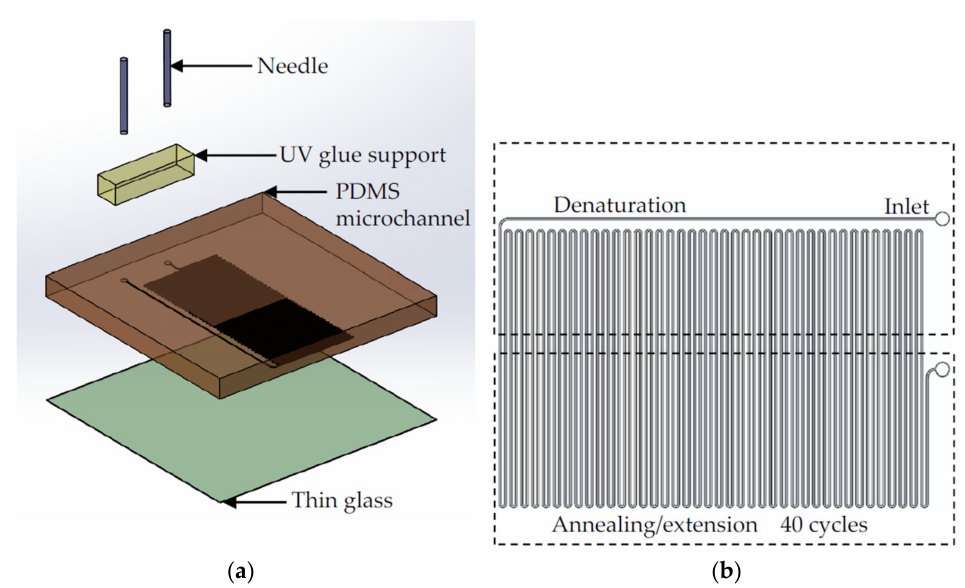
Figure 1. ( a ) Illustration of the flow-through ultrafast PCR chip. The chip is composed of PDMS and thin glass plate of 200 µ m thickness, and a needle is inserted at the inlet and outlet of the sample. ( b ) The chip is designed with 40 thermal cycles and placed on the block heater of high-temperature zone (for denaturation) and low-temperature zone (for annealing/extension); the channel width is 200 µ m, and the influence on ultrafast PCR is observed by changing the length of the